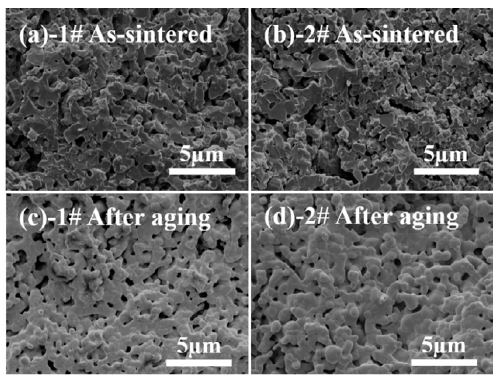
Fig. 3 Fracture surfaces of the ceramics (1# and 2#) before and after thermal aging at 1300 ℃ for 24 h.